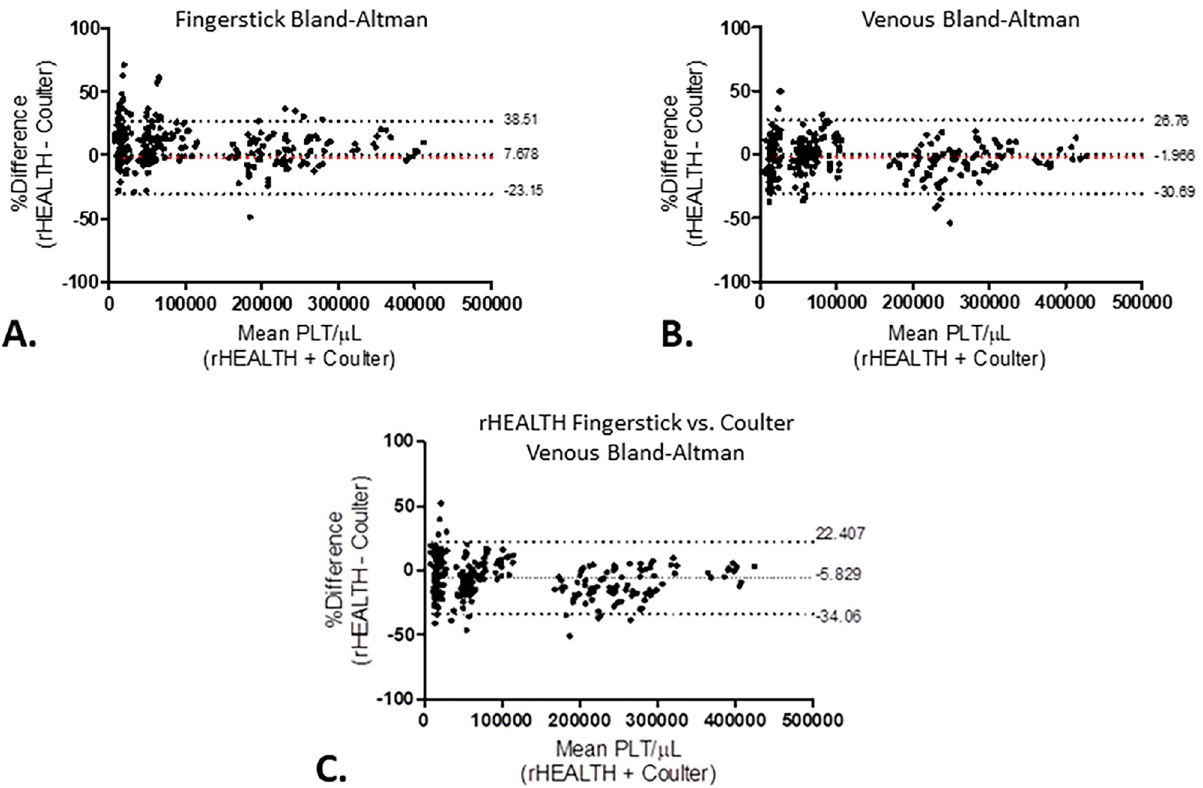
Fig 4. Bland-Altman analysis of the rHEALTH absolute volumetric approach versus Coulter ISLH. The bias is shown with +/- 1.96 SD bounds. (A) Fingerprick samples for both approaches, (B) Venous samples for both approaches, and (C) Bland-Altman of Coulter ISLH venous versus rHEALTH fingerstick